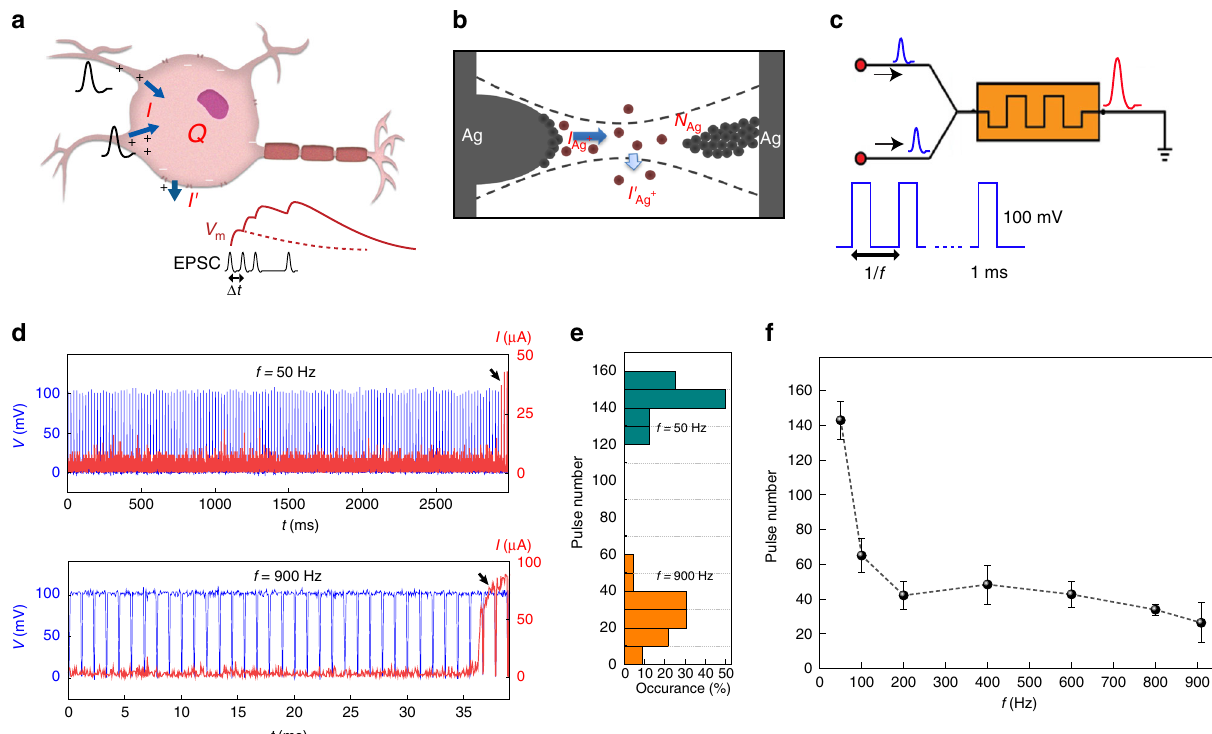
Fig. 4 Protein nanowire arti fi cial neuron displaying temporal integration of inputs. a Schematic of a biological neuron integrating excitatory postsynaptic current (EPSC). I denotes the injected EPSC, I ’ denotes the leaky current through the cell membrane, and Q denotes the net cytosolic charge. The bottom panel is a schematic of temporal integration of EPSC. The membrane potential ( V m ) shows a close-to-linear summation of short-interval EPSC spikes, whereas the summation deviates for long-interval EPSC spikes. b Schematic of proposed dynamics of fi lament formation in the protein nanowire memristor. The dashed lines delineate the given fi lamentary volume. I Ag + denotes injected cationic Ag + current, I ’ Ag + denotes the Ag + diffusion (leaky) current out of the fi lamentary volume, and N Ag denotes the net Ag element in the fi lamentary volume. c Schematic of a leaky integrate-and- fi re arti fi cial neuron built from a protein nanowire memristor. Excitatory postsynaptic potential (EPSP) signals are represented by action-potential alike spikes (100 mV, 1 ms) and their temporal correlation is modulated by frequent f . d The neural fi ring (turn-on, indicated by black arrows) in a protein nanowire device at low- frequency (50 Hz, top panel) and high-frequency (900 Hz, bottom panel) EPSP signals. e Statistics of pulse number required for neural fi ring for low- frequency (50 Hz, cyan) and high-frequency (900 Hz, orange) EPSP signals. f Average pulse number of EPSP signals required for neural fi ring at different frequencies (50 – 900 Hz). The error bars represent the standard deviation (s.d.). The pulse number shows a relatively fl at trend at high frequency (200 – 900 Hz), indicating a close-to-linear temporal integration less sensitive to spike interval. The trend deviates at low frequency ( ≤ 100